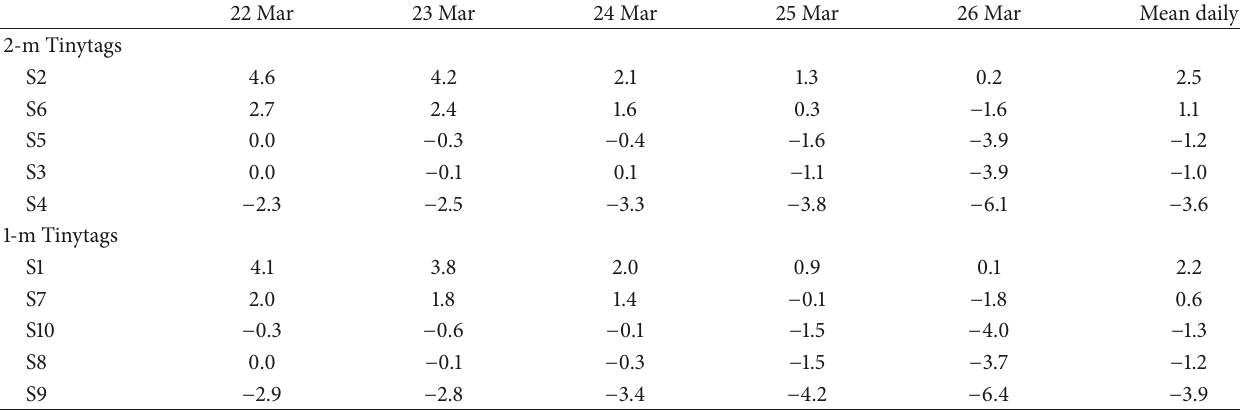
Table 6: Daily and mean daily (22–26 March 2015) temperatures ( ∘ C) for all ten Tinytag sensors (1-m and 2-m elevation at five sites) based on 1-min